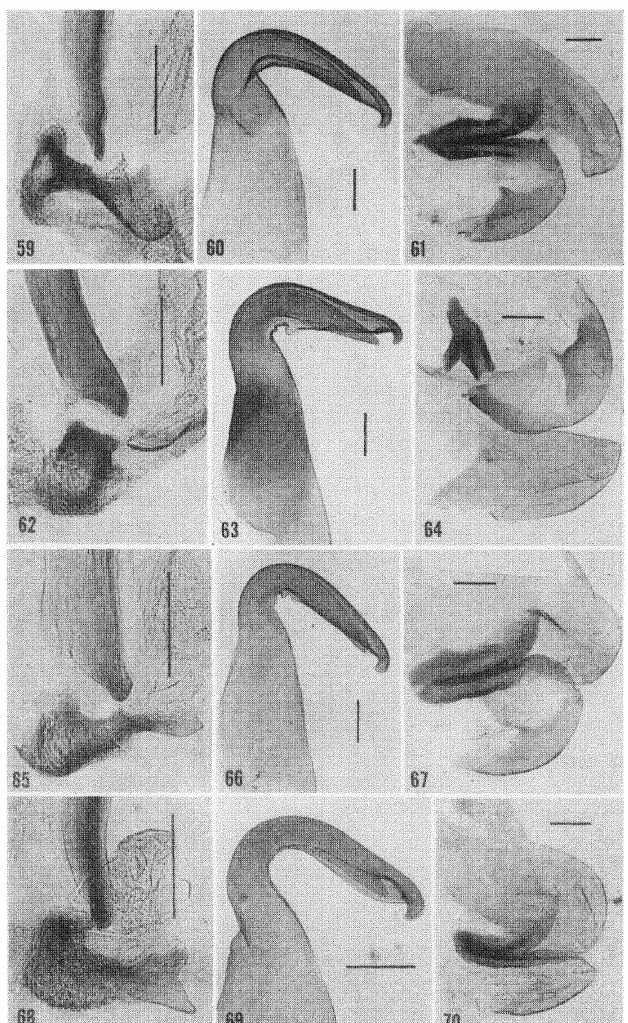
(from / shown in lig. 38). 65-67. (9t0 L). P. thoracica (from $ shown in Fig. 40). 68-70. (991 L). P. reflexa (trom shown in Fig. 41).